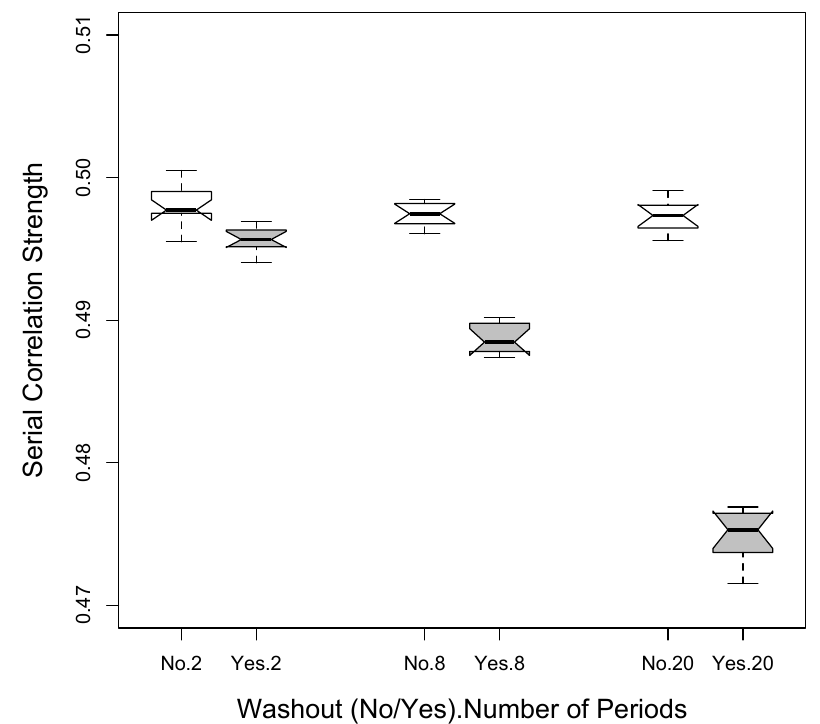
Figure 1. Reduction in serial correlation when washout periods are used based on simulation studies. The settings considered involved a 2 × 200 observation (2 total periods) setting, a 4 × 50 observation (8 total periods) setting and a 10 × 2 observation (20 total periods) setting.